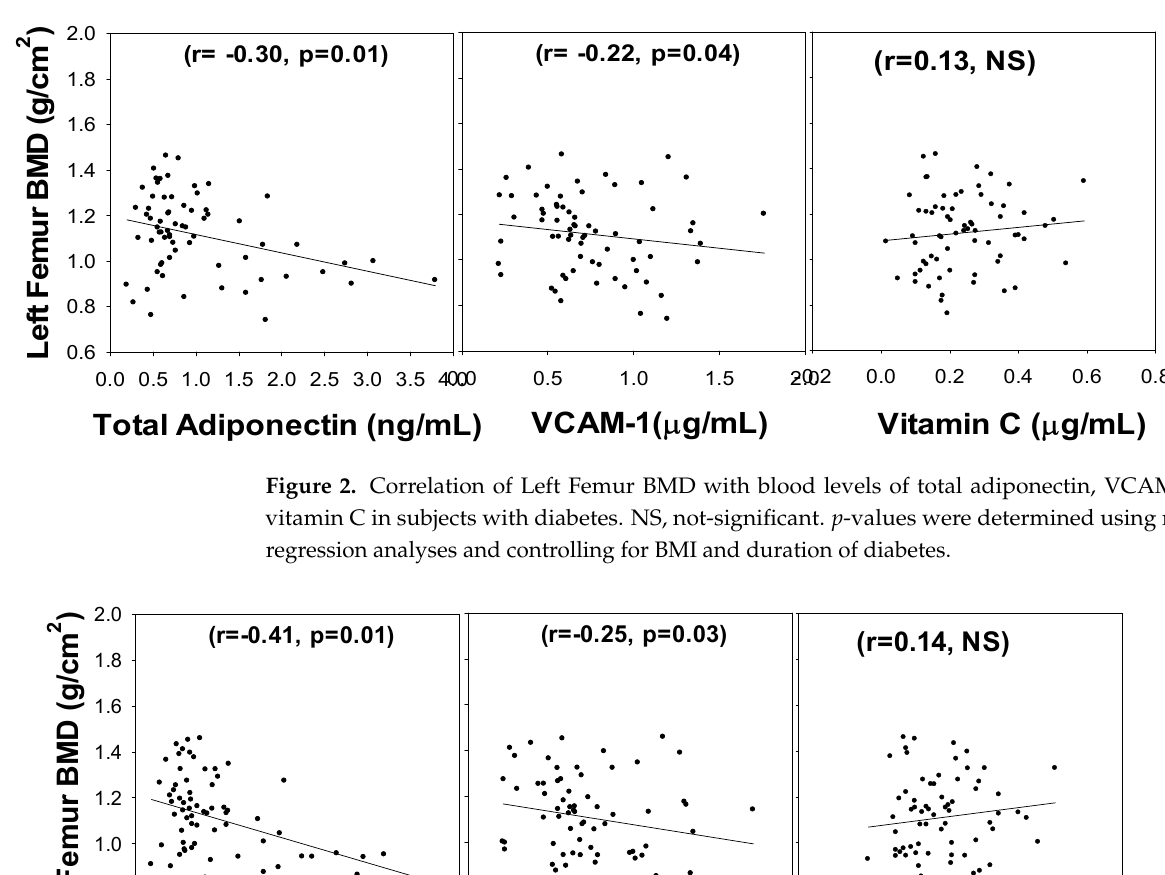
0.8 Figure 1. Correlation of Lumbar spine BMD with blood levels of total adiponectin, VCAM-1, and vitamin C in subjects with diabetes. P -values were determined using multiple regression analyses and controlling for BMI and duration of diabetes. Figure 2 illustrates that while the left femur BMD had a negative association with VCAM-1 (r = 0.22, p = 0.04) and total adiponectin (r= −0.30, p = 0.01) levels, it showed no significant correlation with VC. Similarly, the right femur BMD showed an inverse asso-